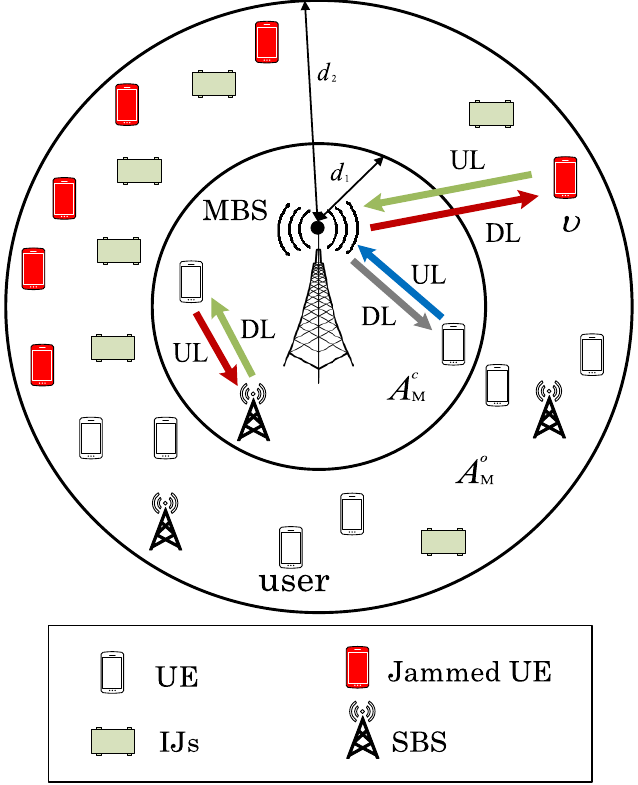
Figure 1. HetNet with RFA and IJs in two-tier. MBS, SBSs, users and IJs follow